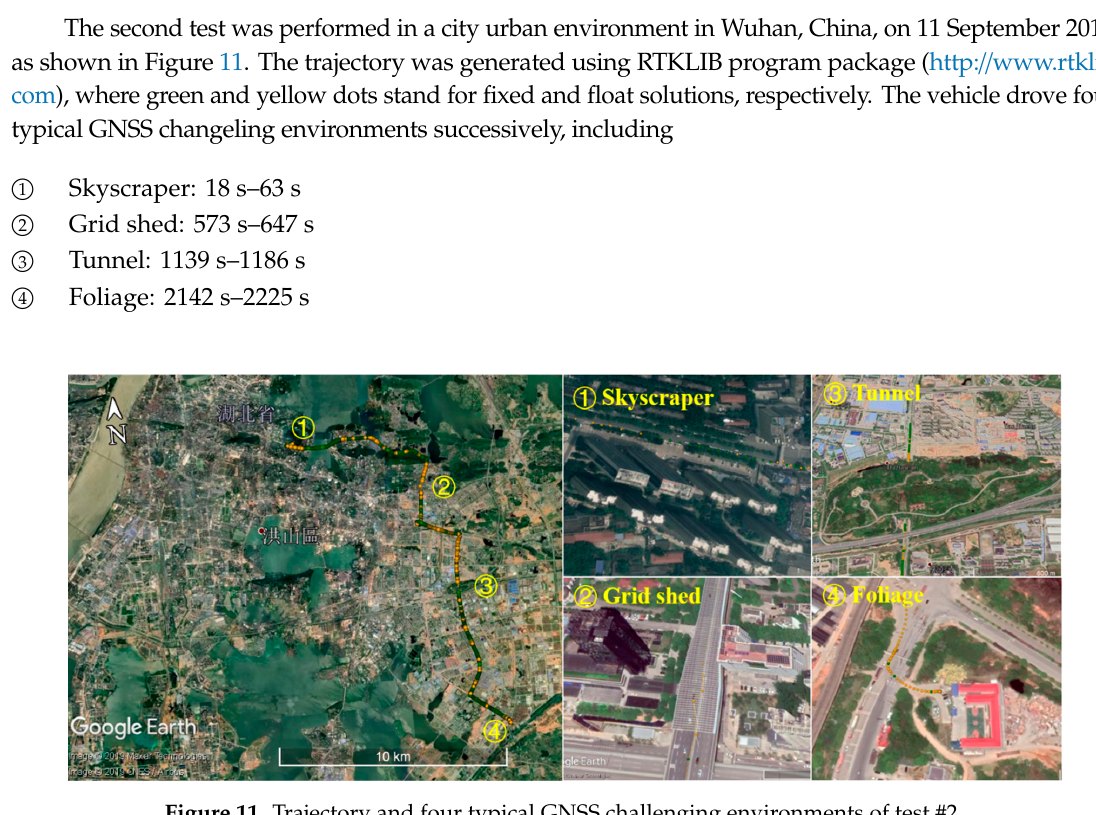
Figure 12. Equipment for test #2.